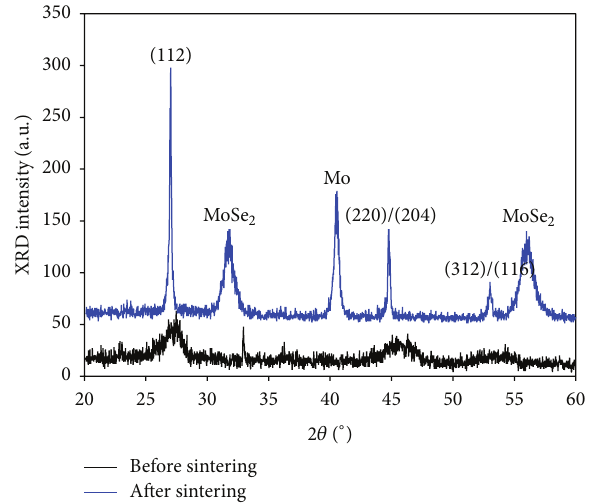
Figure 5: XRD patterns of CIGS samples before and after sintering.